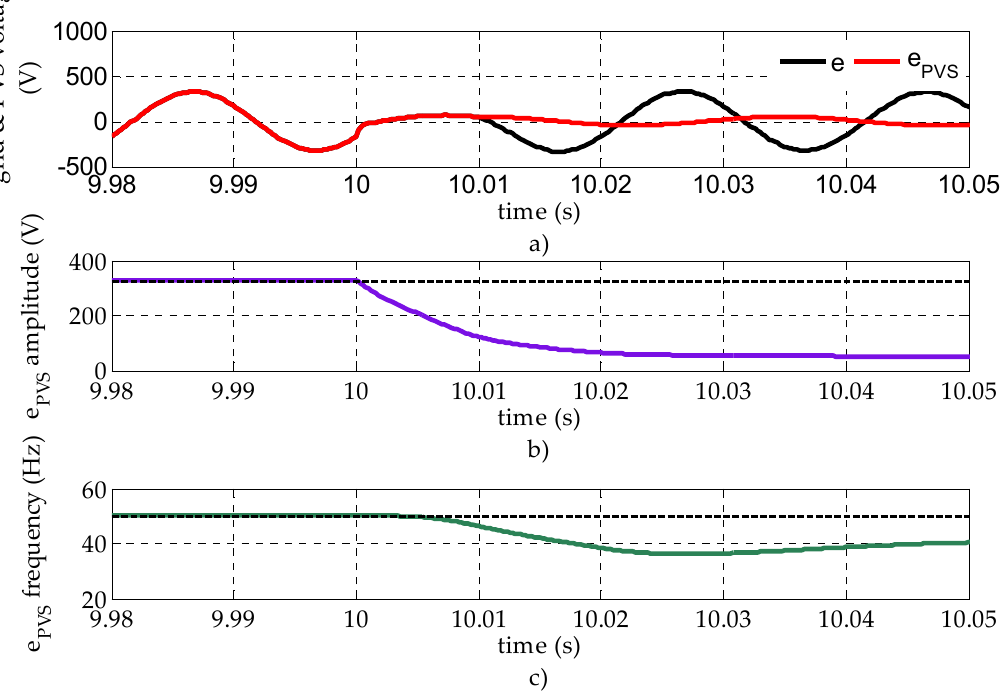
Figure 12. Grid and PVS voltages in case of islanding occurrence. ( a ) e and e PVS waveforms; ( b ) e PVS amplitude; ( c ) e PVS frequency.